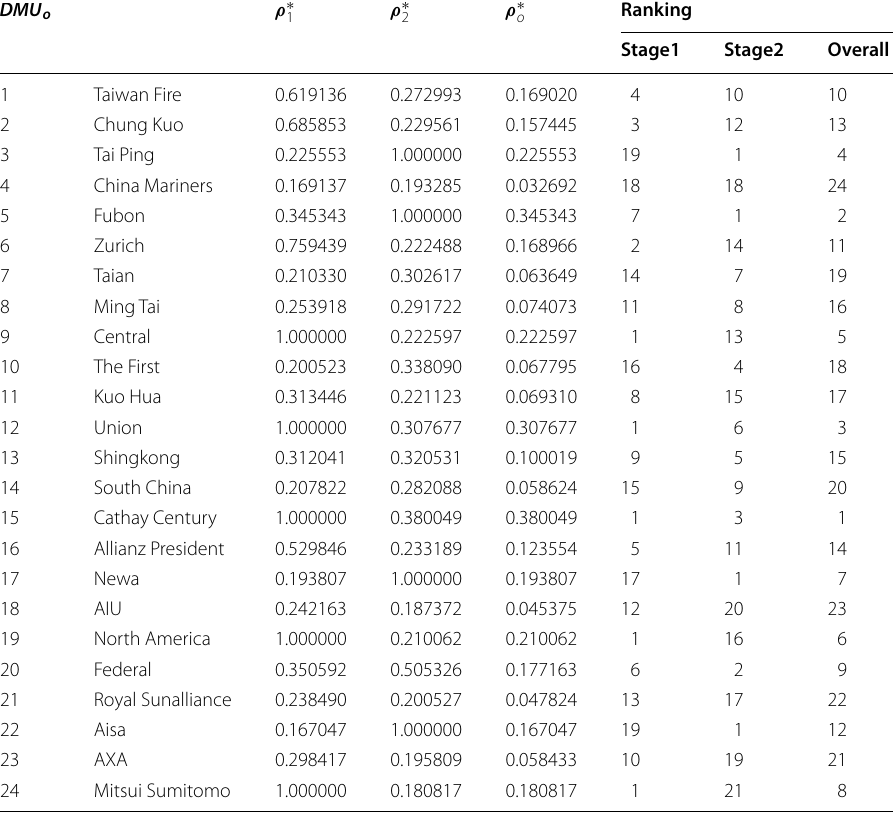
Table 7 Example 3. Results from RDD-R model